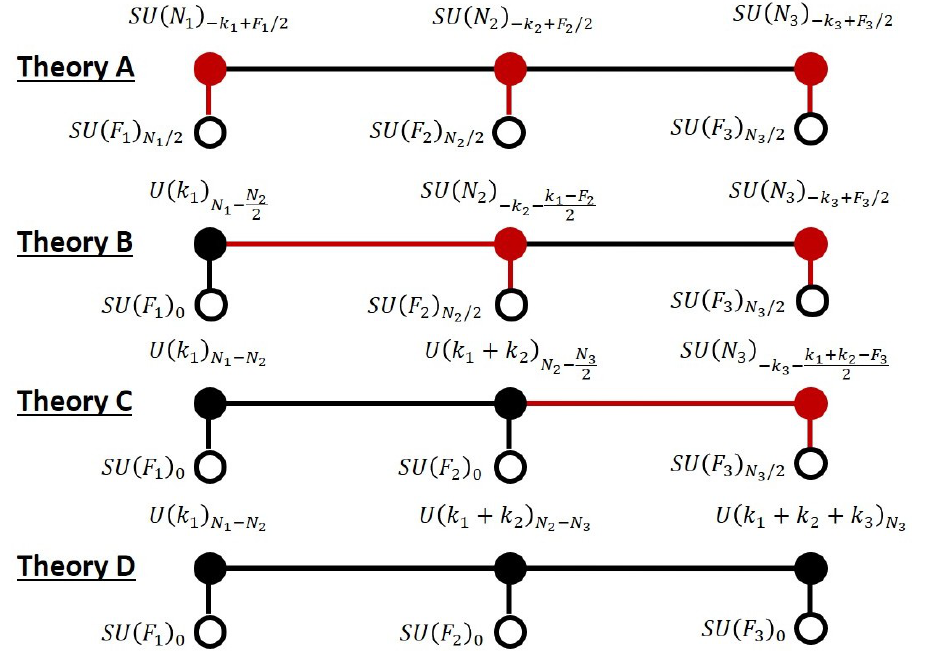
Figure 7. Flavored quiver with fermions on the SU side and scalars on the U side. The red/black nodes correspond to U and SU gauge groups, respectively. The red and black links are fermions and scalars. The white nodes are background (cid:13)avor